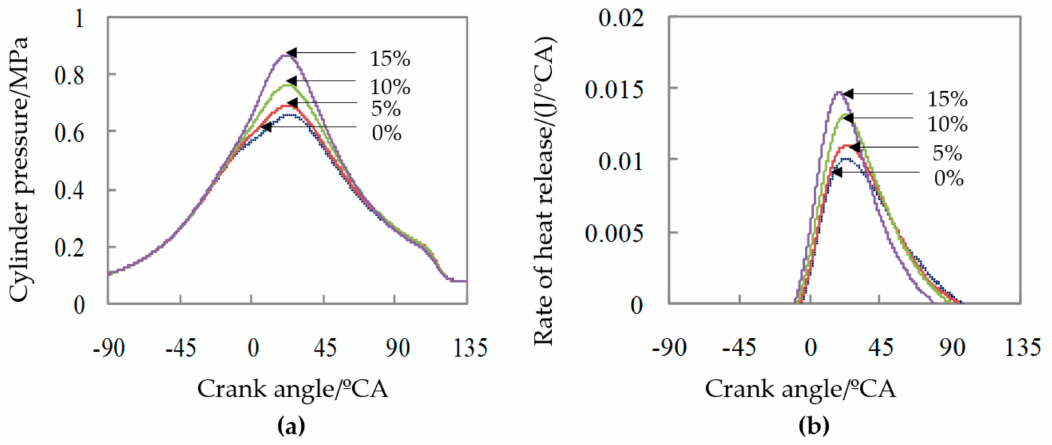
Figure 13. ( a ) E ff ect of nitromethane on the cylinder pressure; ( b ) E ff ect of nitromethane on the rate of heat